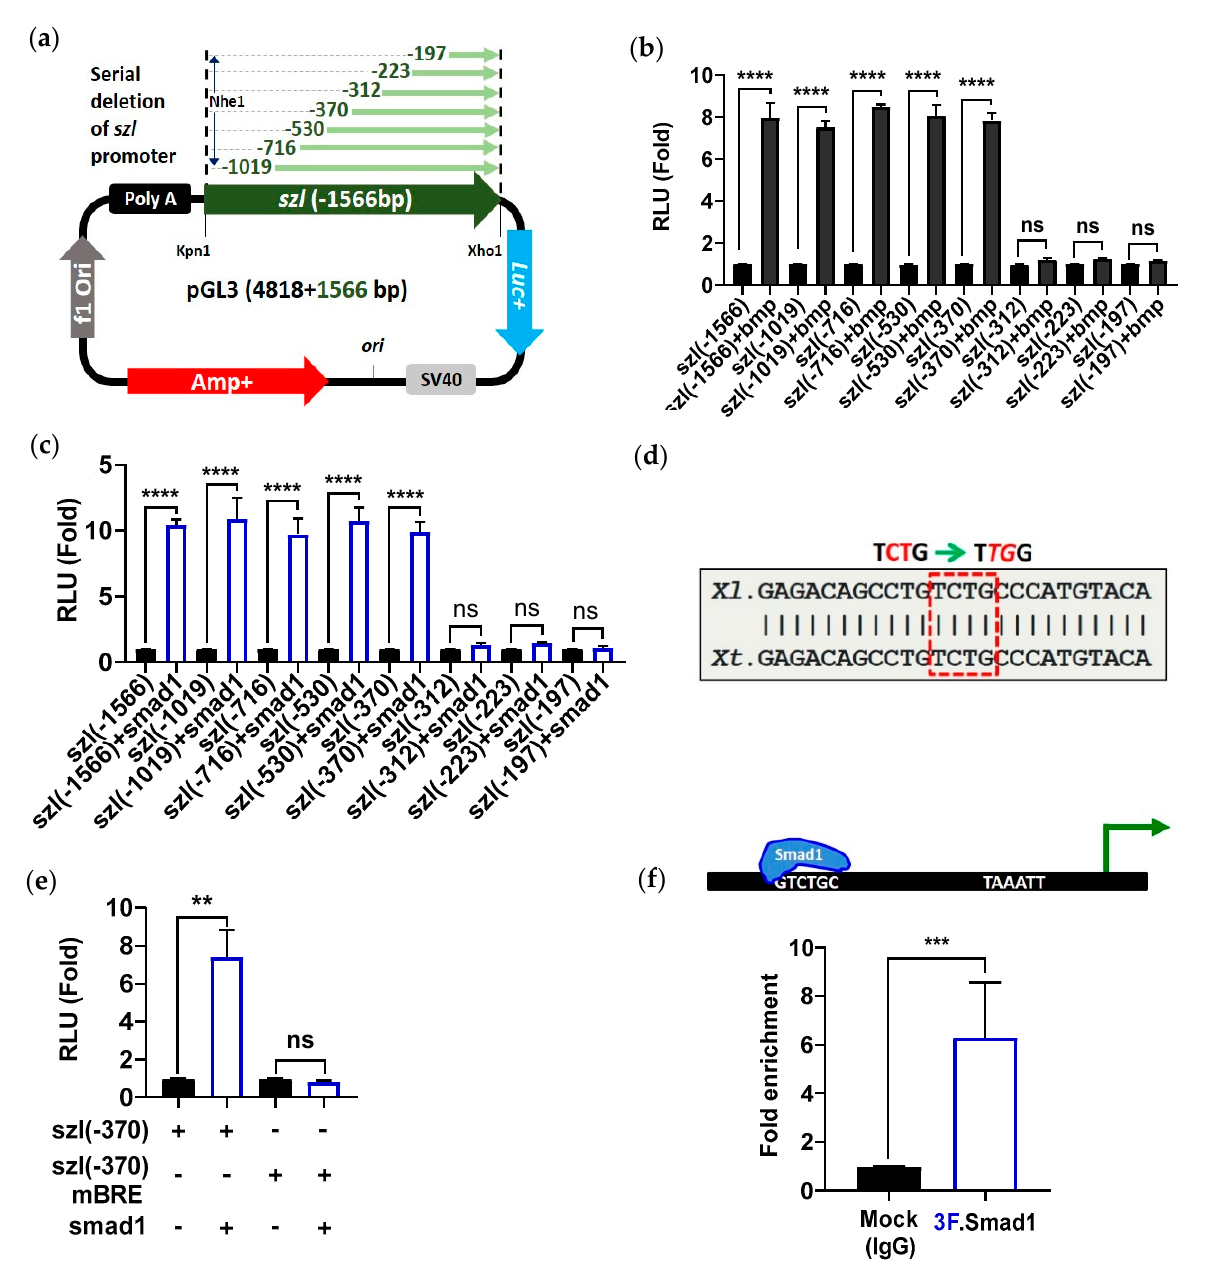
Figure 2. Bmp4 signaling upregulates szl reporter gene activity via Smad1 regulatory response elements within the szl promoter: ( a ) Schematic diagram of serially deleted constructs of szl promoter. ( b ) Reporter gene activities of the serially deleted constructs of szl promoter injected with or without bmp4 and ( c ) smad1 mRNAs. ( d ) Conserved region of szl promoter consisting of a Bmp4 response element (BRE) (outlined within the dashed red box). ( e ) Luciferase reporter gene activity of szl(-370) wild type and mutated BRE constructs injected with or without smad1 mRNA were examined. ( b , c , e ) p ≤ 0.01 for **, p ≤ 0.001 for ***, p ≤ 0.0001 for ****, ns (non-significant) were the assignments for significance. ( f ) Embryos were injected with 3flag-smad1 mRNA and quantitative ChIP-PCR was performed with anti-Flag immunoprecipitated genomic DNA using specific primers for the szl promoter fragment having the Smad1 binding site. Fold enrichment method used to normalize ChIP- qPCR. Smad1 binding scheme is given in the upper part of figure. (SRE: Smad1 response elements).